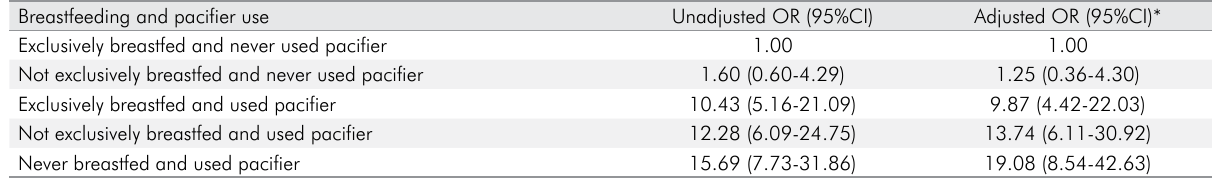
Table 2. Unadjusted and adjusted association between breastfeeding and pacifier use with malocclusion. Logistic Regression Analysis (n =